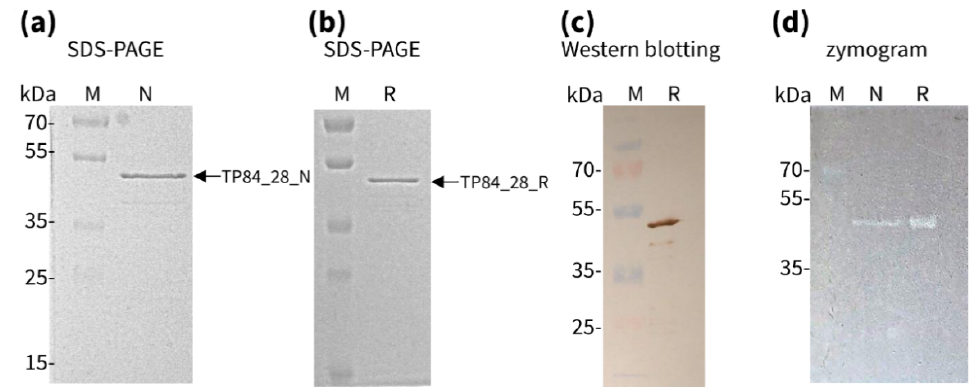
Figure 2. Identification of TP84-28 endolysin. ( a ) SDS-PAGE analysis of native TP84_28 proteins: